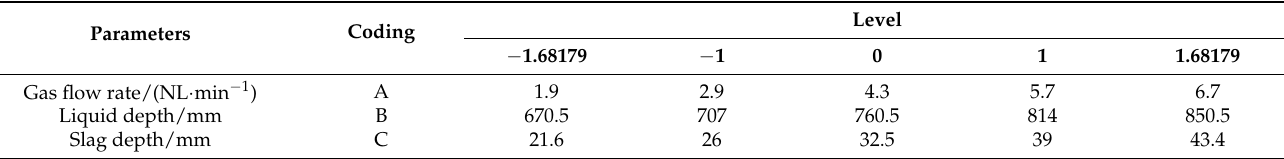
Table 6. Experimental factors and levels of CCD experimental